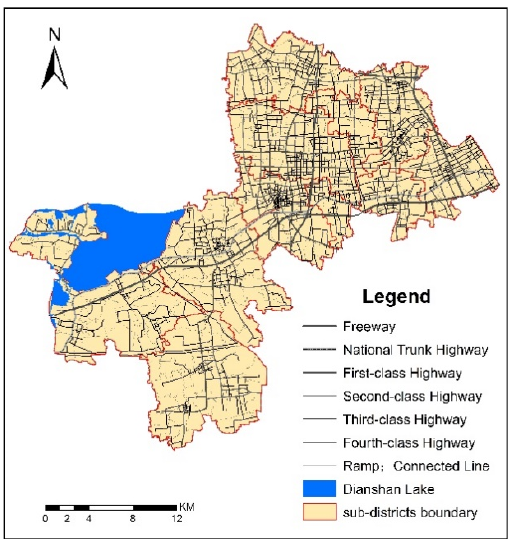
Figure 3. The road network in Qingpu.